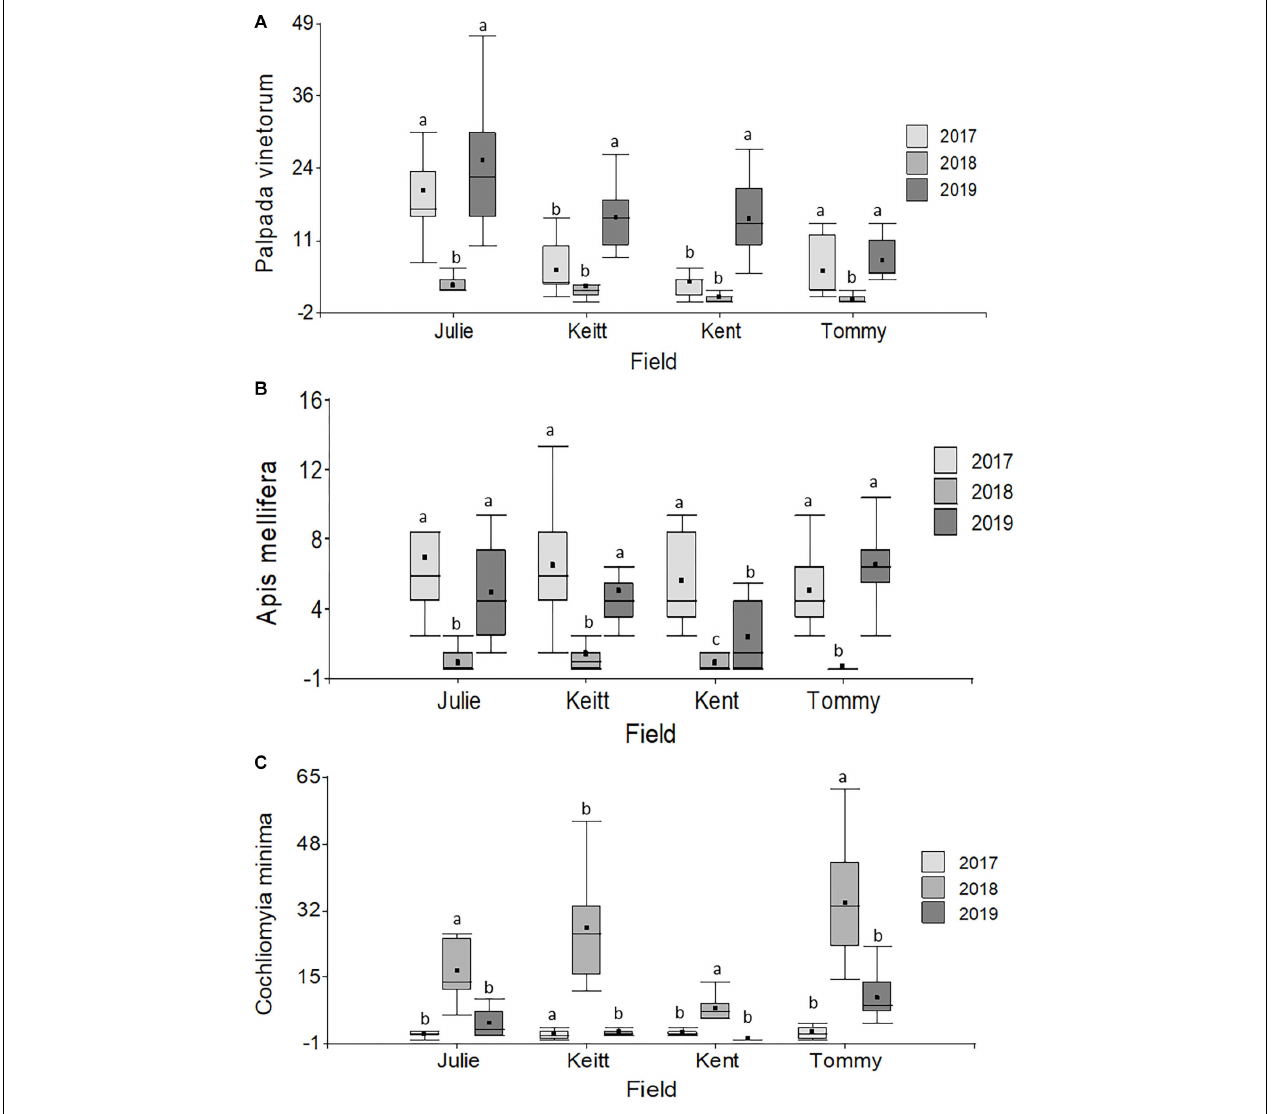
FIGURE 3 | Boxplots illustrating differences in insect abundances per field (Julie, Keitt, Kent, Tommy Atkins) per year for the three most dominant flower visitors. (A) Palpada vinetorum , (B) Apis mellifera , (C) Cochliomyia minima. Repeated Measures analyses performed for each year on each field detected significant differences across years all insect species ( Table 2 ). Different letters within a field indicate significant differences among